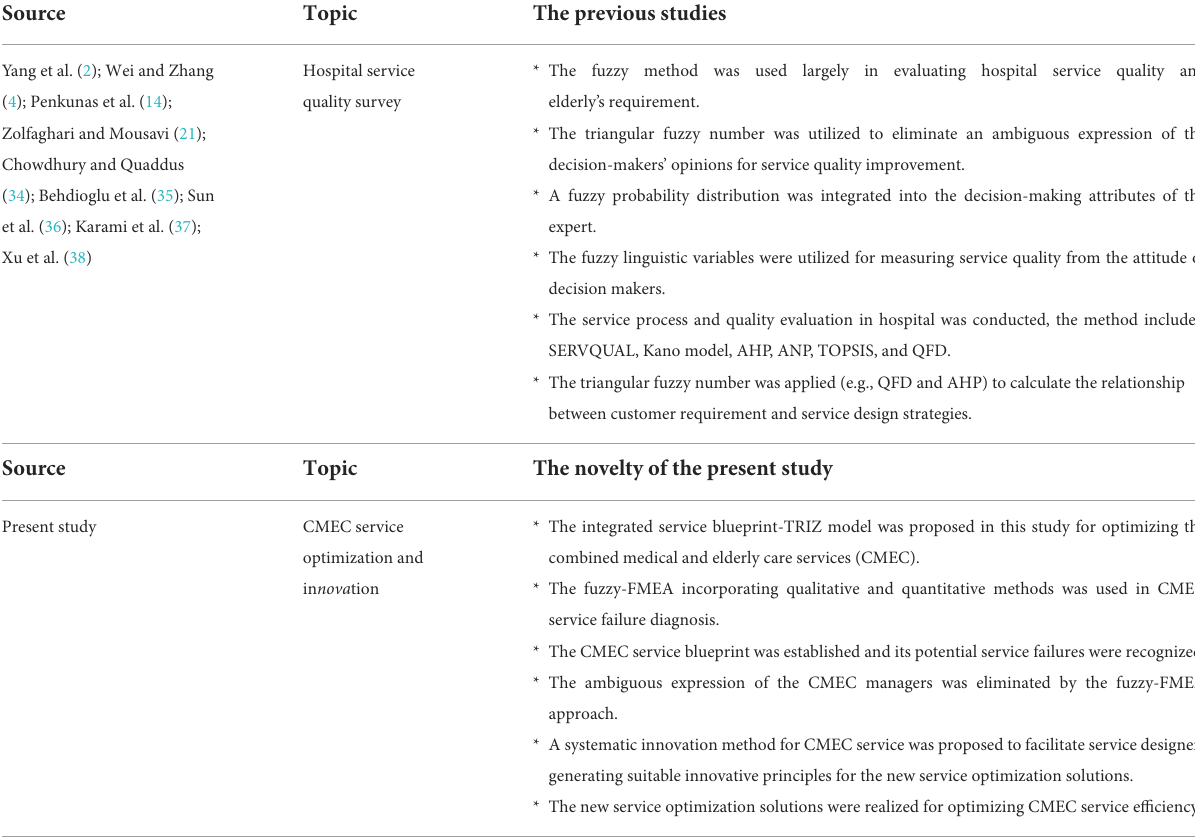
TABLE 14 The novelty of the present study used in CMEC compared with the existing studies.